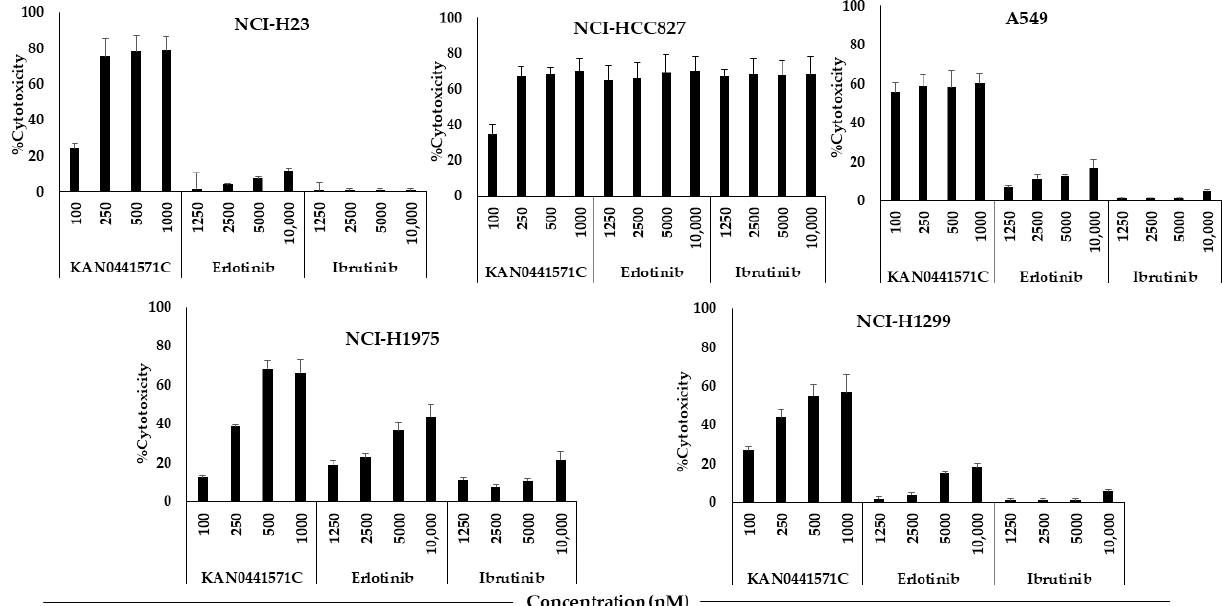
Figure 2. Cytotoxicity (MTT) (72 h) in 5 lung cancer cell lines incubated with various concentrations of KAN0441571C, erlotinib, or ibrutinib.